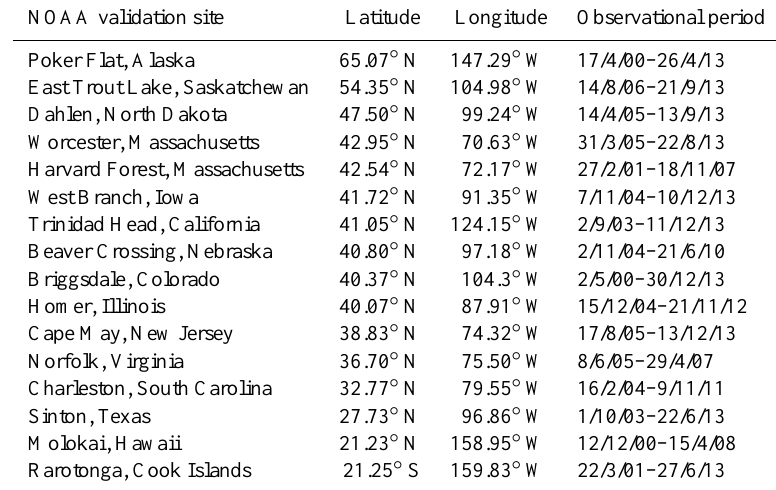
Table 1. NOAA validation site locations.